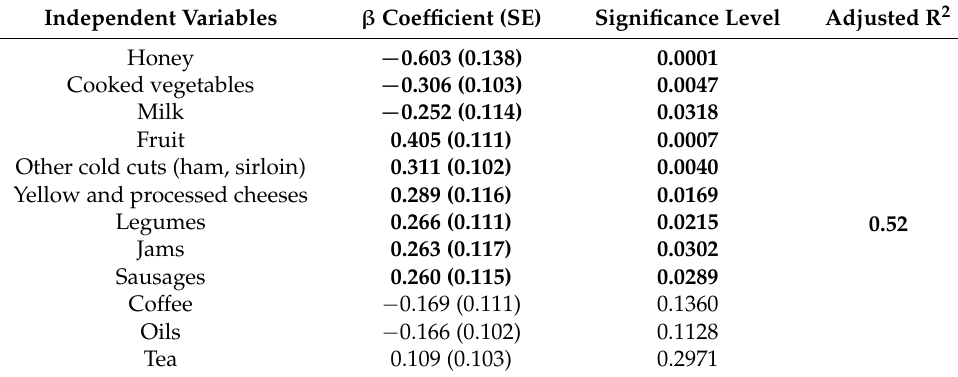
Table 7. Stepwise multiple linear regression analysis of the influence of the frequency of consuming food products on the concentration of UCHL1.